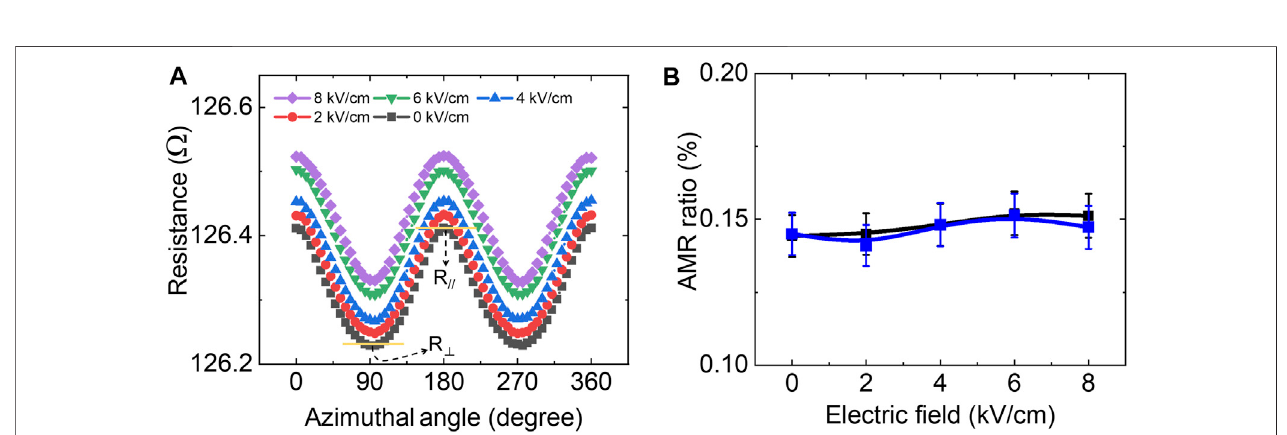
FIGURE 3 | (A) and (B) Magnetoresistance ratio under parallel and perpendicular modes, respectively. Herein, magnitude of the magnetic fi eld is set to ~20 Oe to illustrate the E- fi eld modulation of spin-dependent transport behavior.